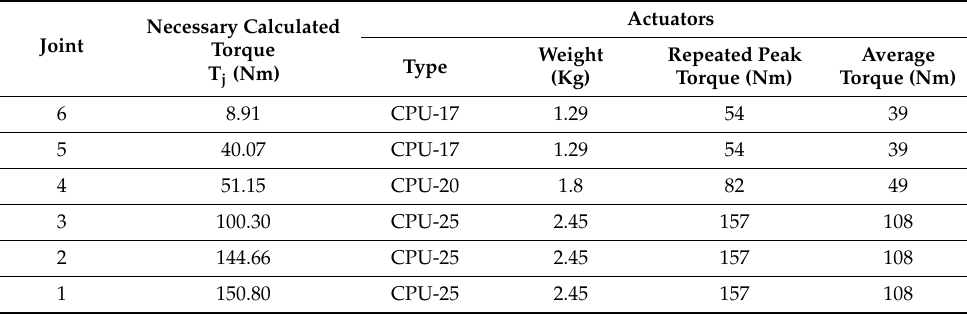
Table 5. Actuator selection based on calculated torque